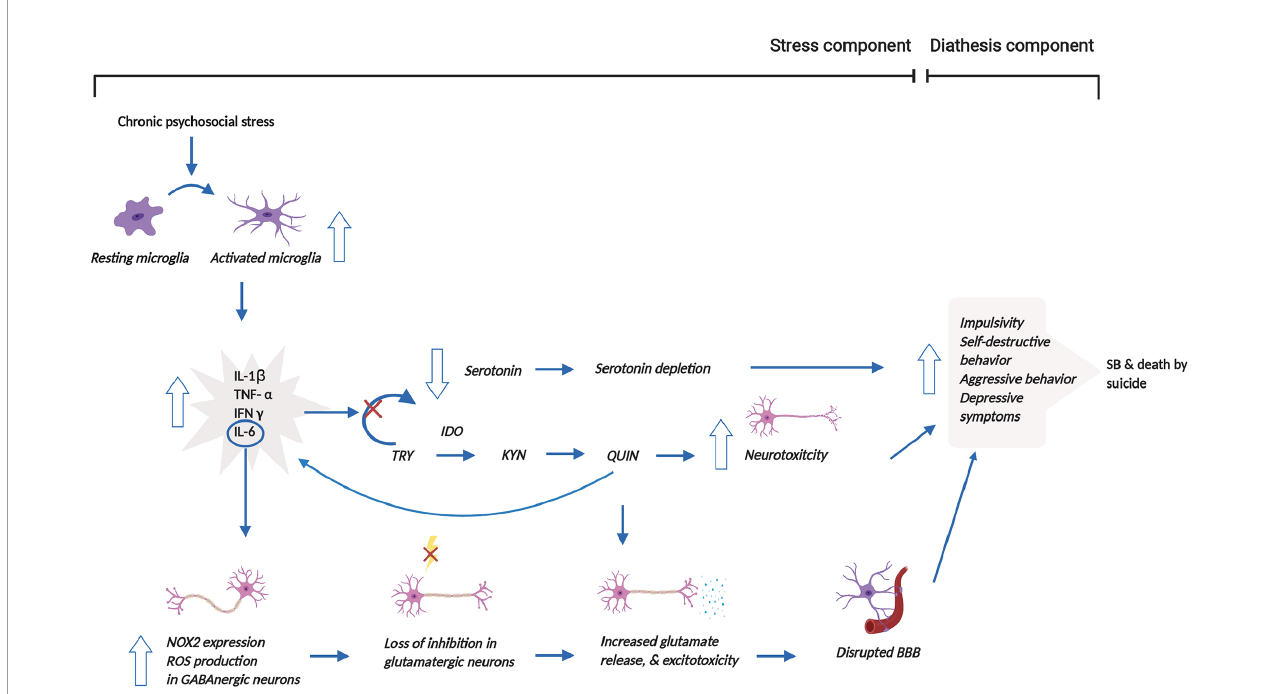
FIGURE 2 | Reconceptualized clinical model of SB incorporating microglial dysregulation. This model proposes that prolonged psychosocial stress leads to the over-activation of microglia and associated release of pro-in fl ammatory cytokines. The release of pro-in fl ammatory cytokines stimulates the shift from serotonin to KYN synthesis through the induction of IDO1. This shift results in the depletion of serotonin. The production of QUIN from KYN synthesis, in addition, increases neurotoxicity. Moreover, increased QUIN production directly leads to heightened glutamate release and associated excitotoxicity but also indirectly causes this elevation by increasing IL-6 levels. Increased glutamate release and excitotoxicity contribute to the disruption of the BBB. Altogether, all these mechanisms contribute to behavioral manifestations, which may then result in SB and/or death by suicide. This fi gure was created with BioRender.com. BBB, blood brain barrier; IDO1, indoleamine 2,3-dioxygenase; IFN- g , interferon gamma; IL-1 b , interleukin-1 b ; IL-6, interleukin-6; NOX2, NADPH oxidase; KYN, kynurenine; QUIN, quinolinic acid; ROS, reactive oxygen species; SB, suicidal behavior; TNF- a , tumor necrosis factor- a ; TRY,